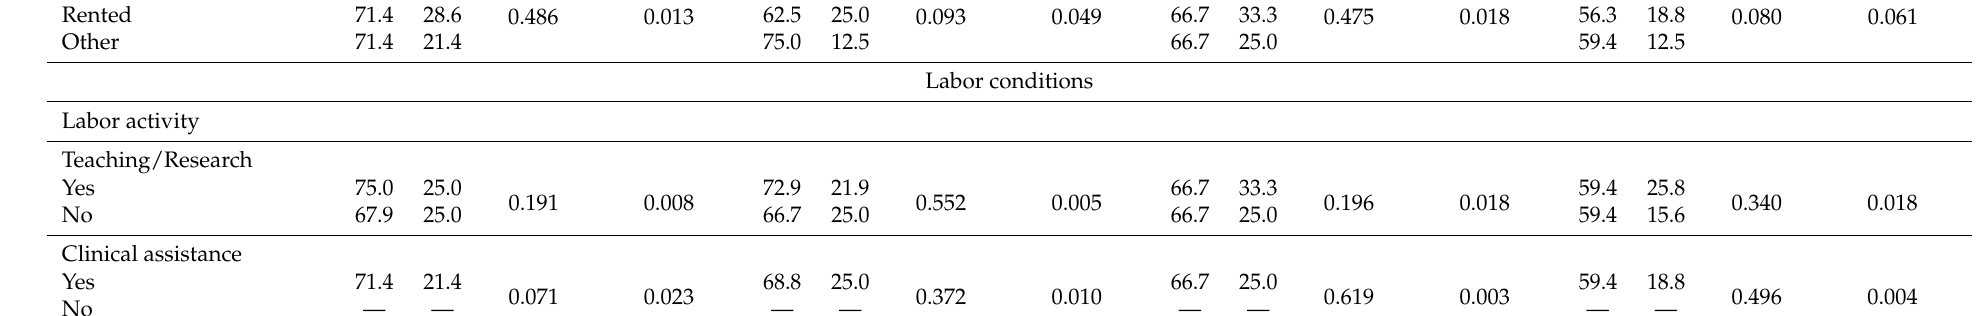
WHOQOL-BREF Dimensions Social